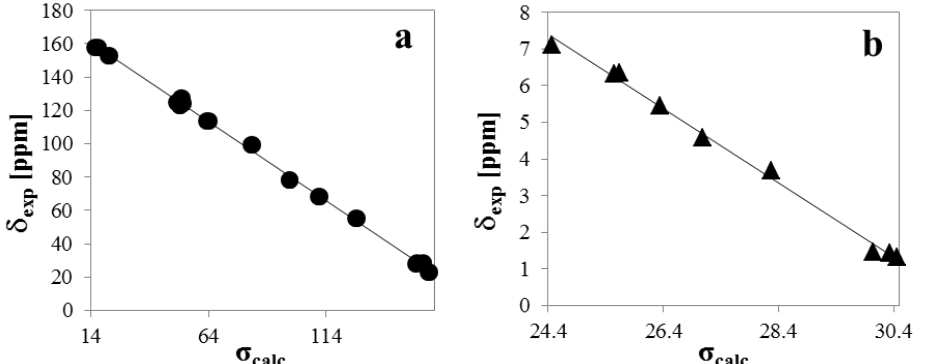
, CHCl ) vs. the isotropic magnetic exp 3 = a + b· σ exp calc